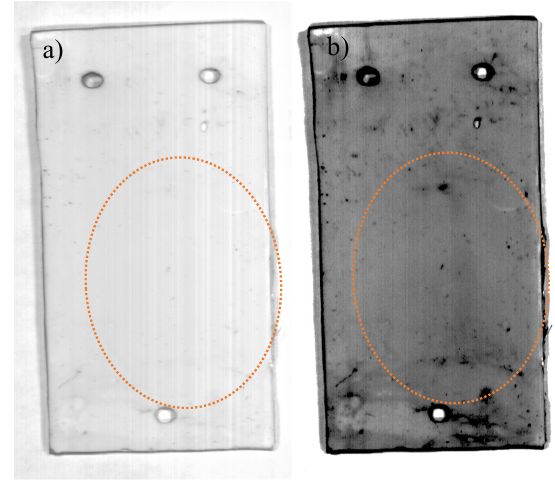
Figure 11. Sample in Figure 9 after being thoroughly cleaned with alcohol ( a ) and hyperspectral false color image ( b ).